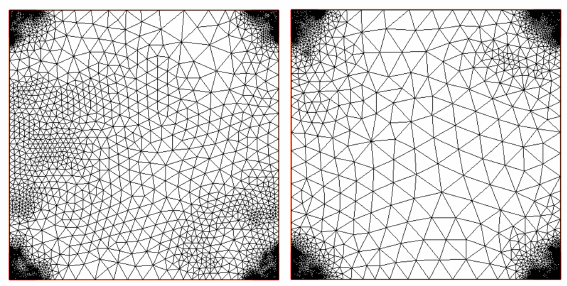
Figure 3. Adapted meshes for example 1 by using the residual-based error estimator. ( Left ) The last performed step, where the mesh is mostly refined at the four corners. ( Right ) The final mesh obtained with c = 0.3; the corners are highly refined with respect to the rest of the